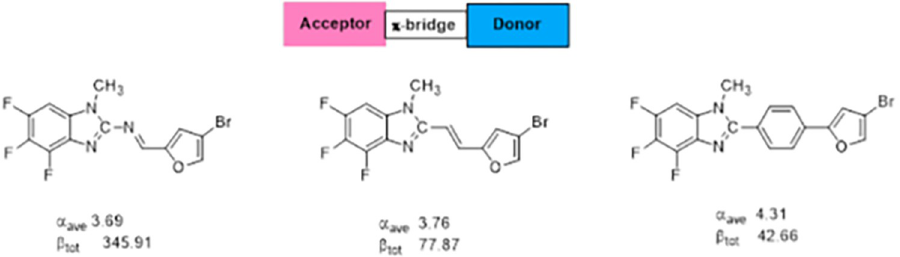
Fig 17. α ave and β tot of fuberidazole derivatives with π -bridge in between donor and acceptor units. The values for α are given in 10 − 23 esu and for β tot in 10 − 31